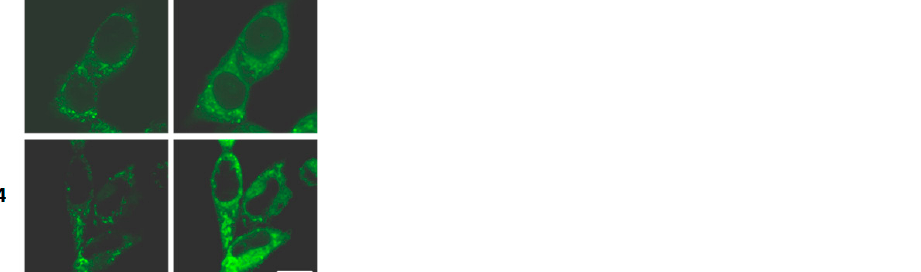
Figure 4. ROS generation after light excitation of photosensitizers accumulated by HCT116 cells for 24 h, final concentration 10 μ M. Photoexcitation was carried out with microscope laser for 30 s at 405 nm. Bar, 15 μ m.